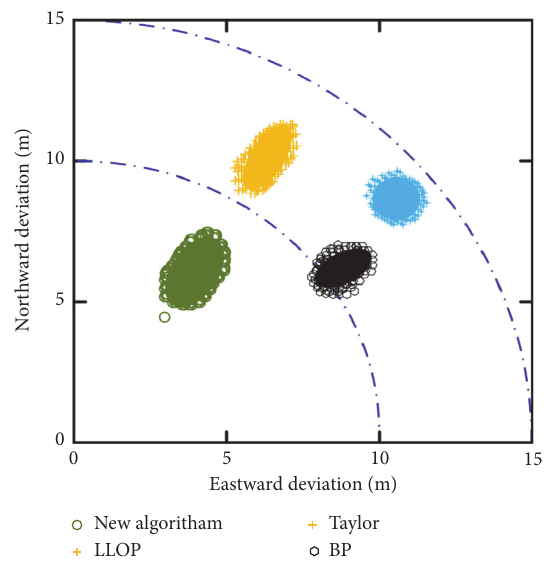
Figure 8: Deviation of different localization algorithms.